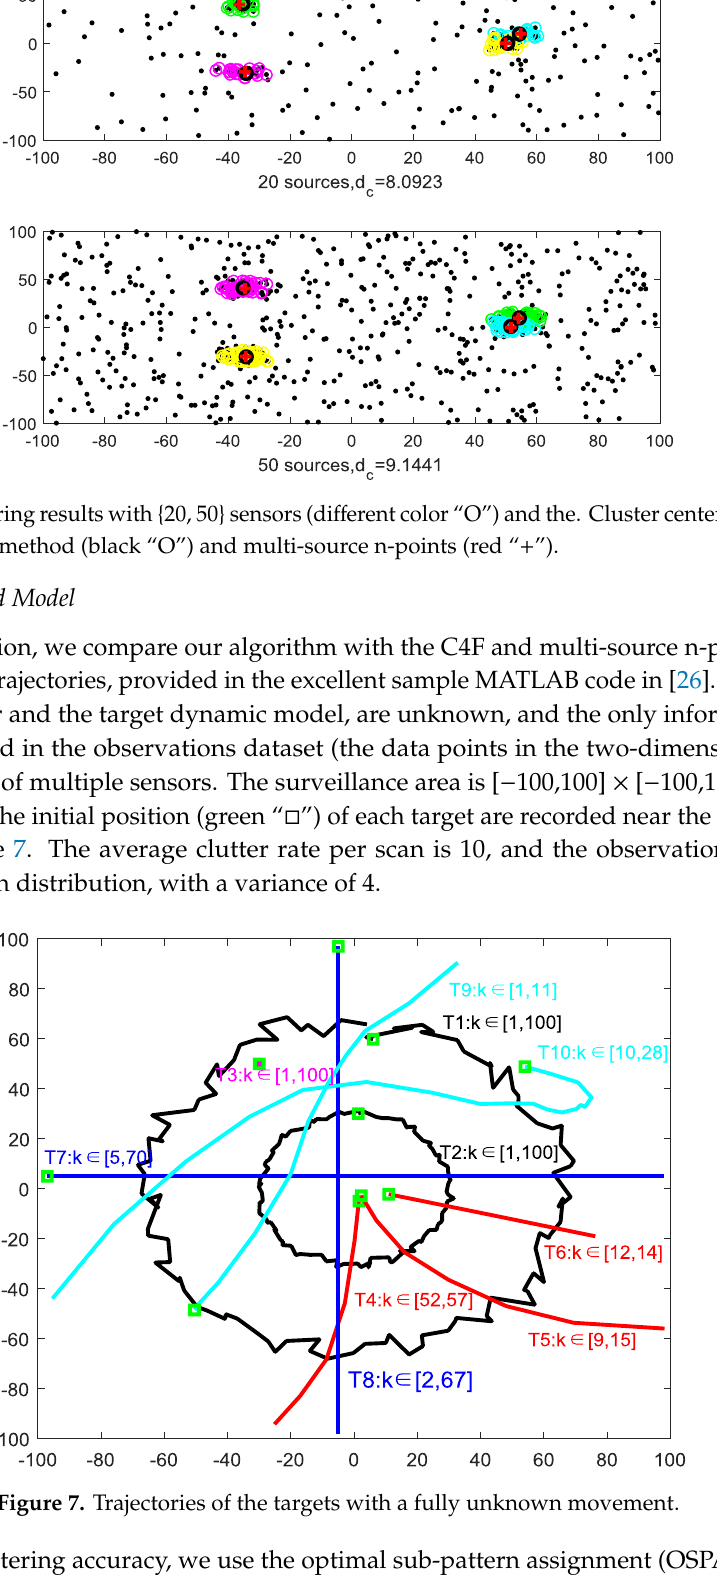
Table 3. Cutoff distance of different clustering methods (m).